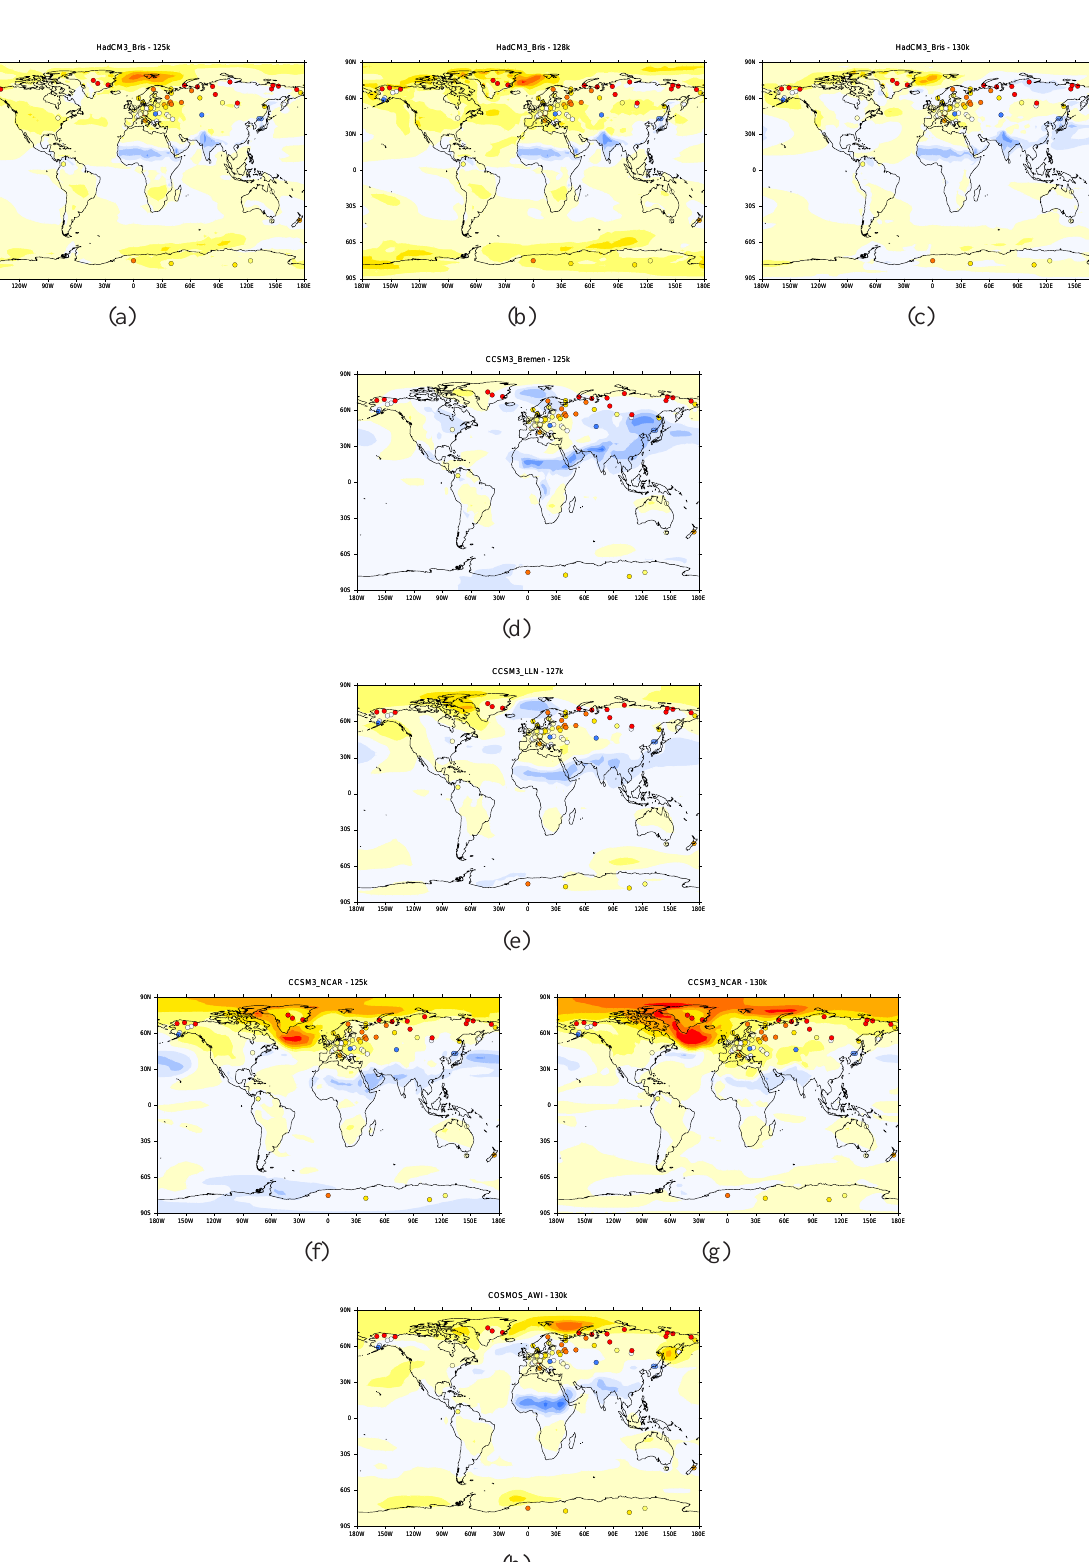
Fig. 5. Simulated annual mean surface air temperature change, LIG minus pre-industrial, for each model and each snapshot carried out. Also shown are the terrestrial data points of Turney and Jones (2010). (a) HadCM3 Bris 125k, (b) HadCM3 Bris 128k, (c) HadCM3 Bris 130k, (d) CCSM3 Bremen 125k, (e) CCSM3 LLN 127k, (f) CCSM3 NCAR 125k, (g) CCSM3 NCAR 130k, (h) COSMOS AWI